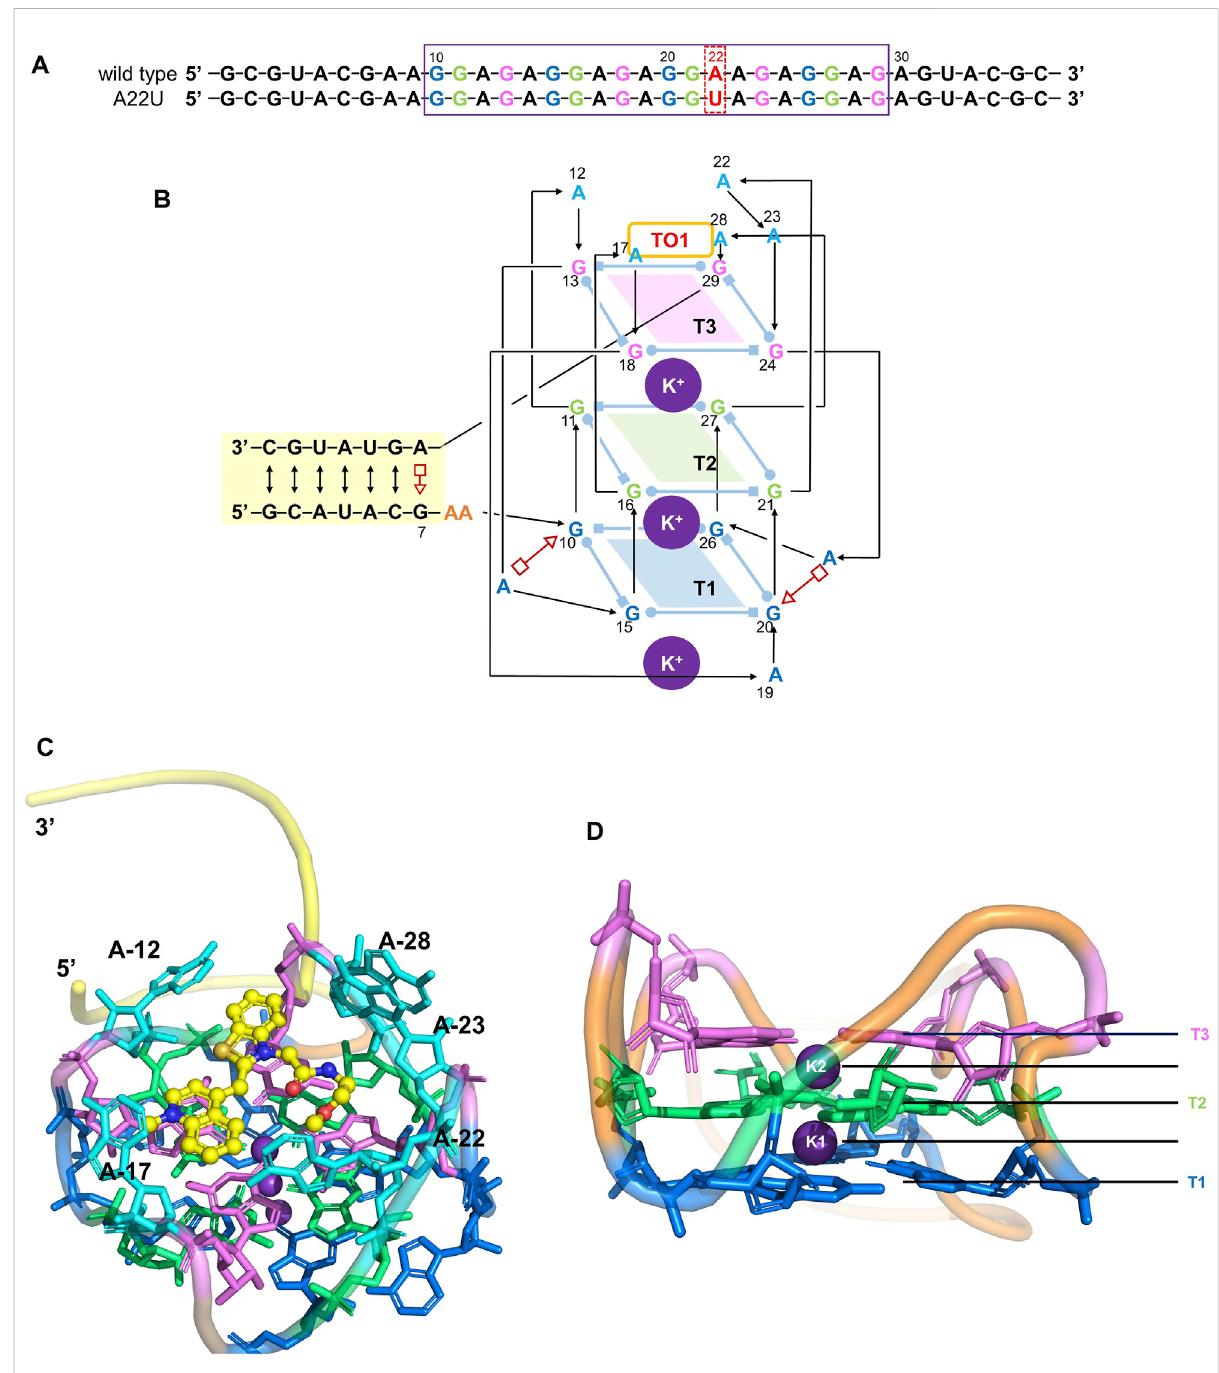
FIGURE 1 Structure of the Mango-II. (A) : nucleic acid sequence of both wild-type and A22U mutate of Mango-II, with the purple box highlighting the G-quadruplex component (site 10 – 29). (B) : Secondary structure of the wild-type complex. Base pairs are represented with Leontis − Westhof symbols, and the connectivity of the main chain is denoted by arrows and lines. Three G-quadruplex layers have been illustrated by blue (T1), green (T2),andviolet(T3)planes. (C) :CartoonrepresentationofthecrystalstructureofMango-II_TO1-Biotincomplex(PDBid:6C63) (D) .Sideviewof the G-quadruplex (2 K + have been abbreviated as K1 and